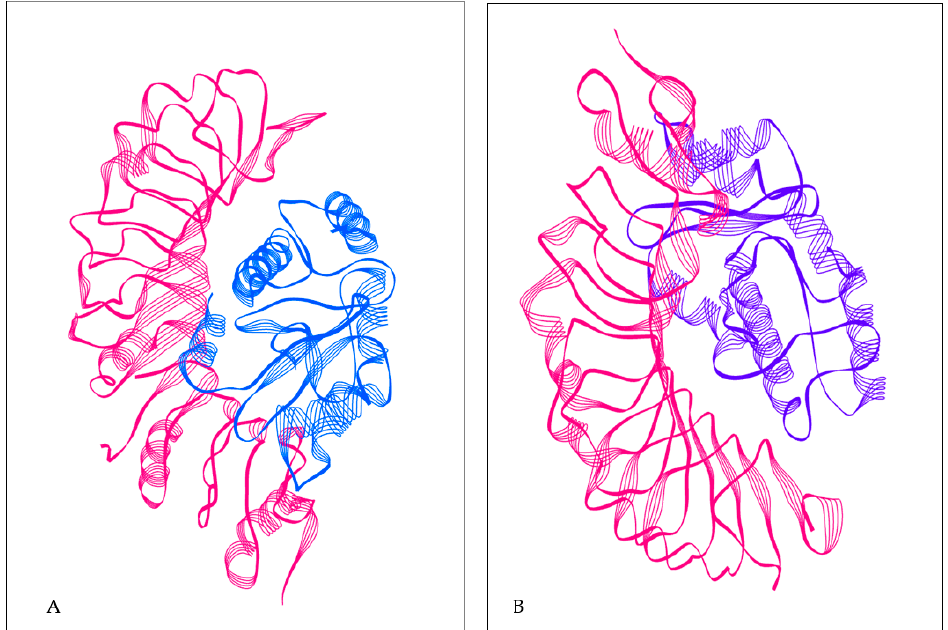
Figure 4. ( A ) TLR2 with constructed vaccine; TLR2 structure in pink color; constructed vaccine in blue color. ( B ) TLR4 with constructed vaccine; TLR4 structure in pink color; constructed vaccine in purple color.